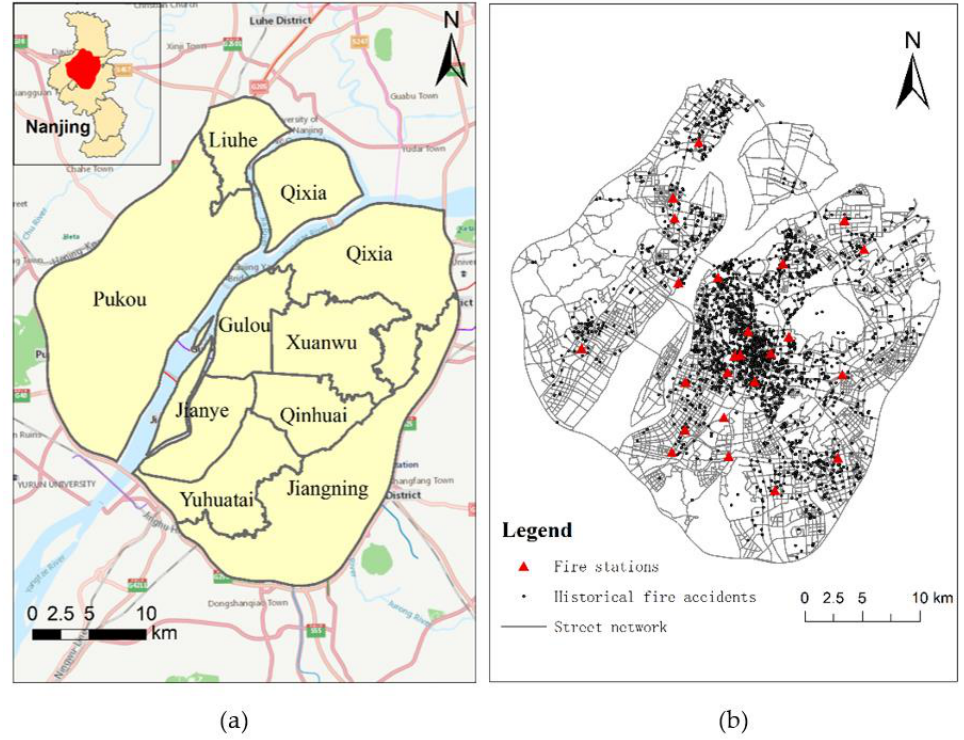
Figure 5. The study area ( a ) and data ( b ): the road network, fire stations, and historical fire incident data.